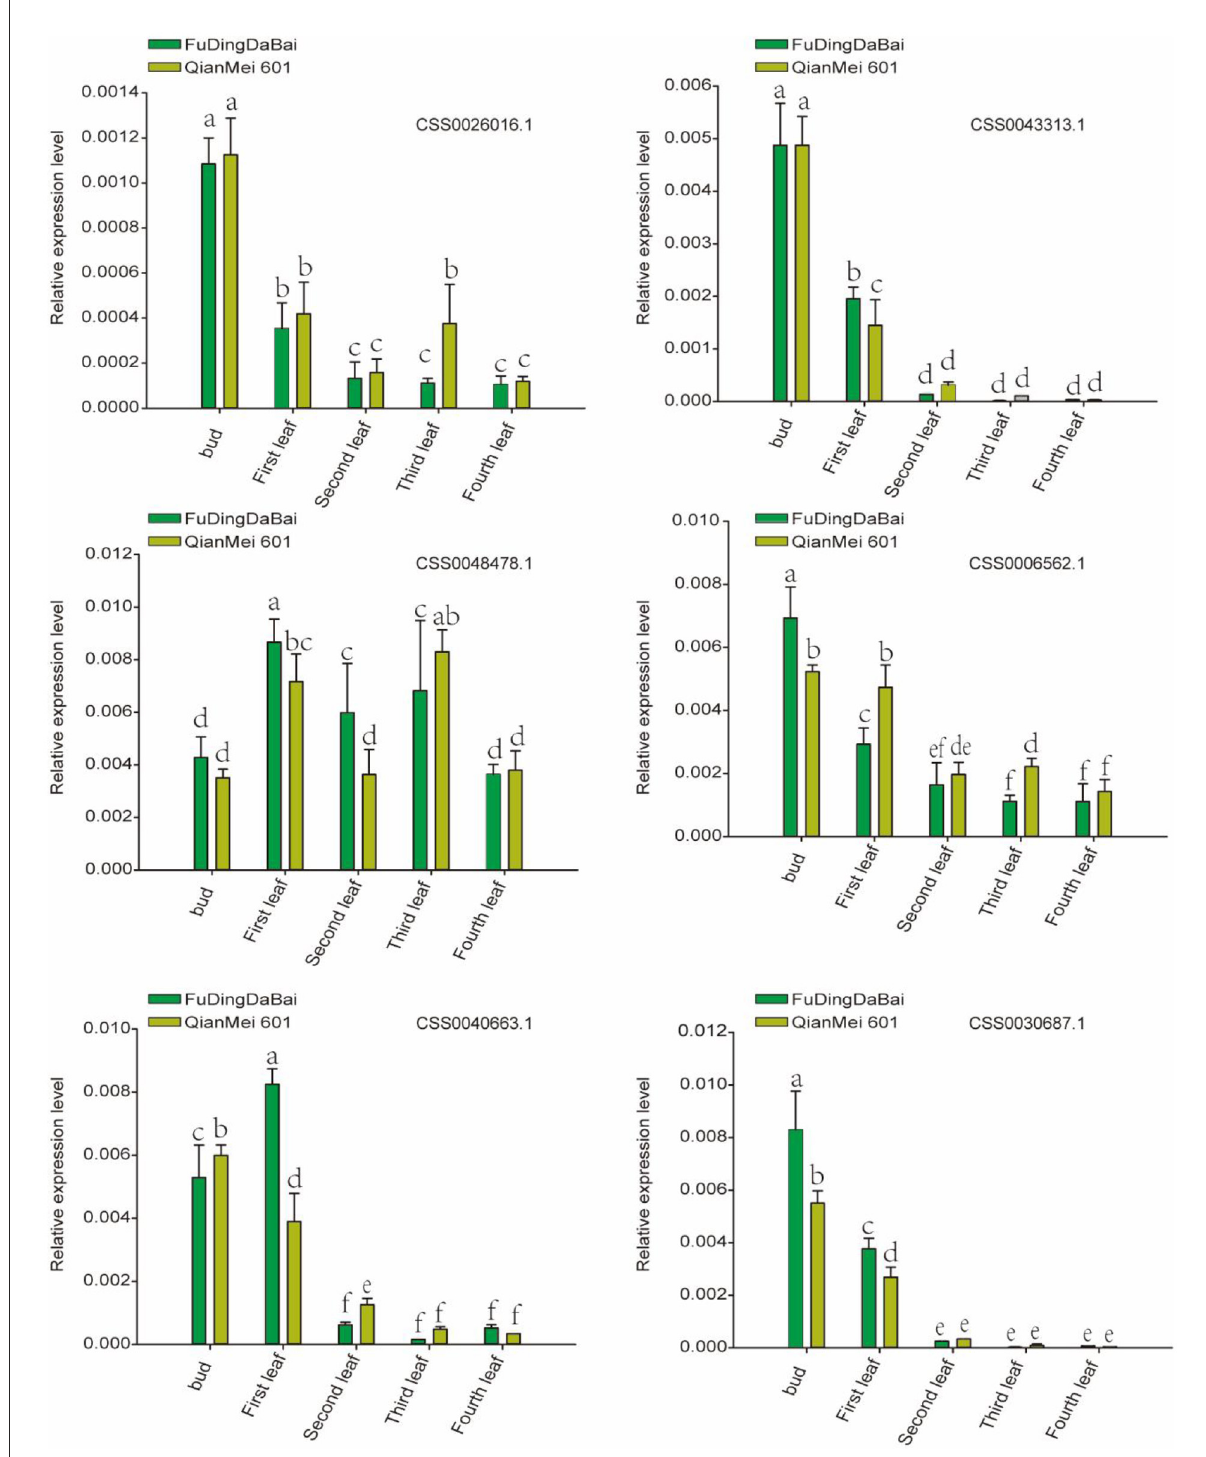
FIGURE7 RT-qPCR verified the expression levels of six candidate genes in different tissues of “QianMei 601” and “FuDingDaBai”. Different letters indicate significant differences (P < 0.05).